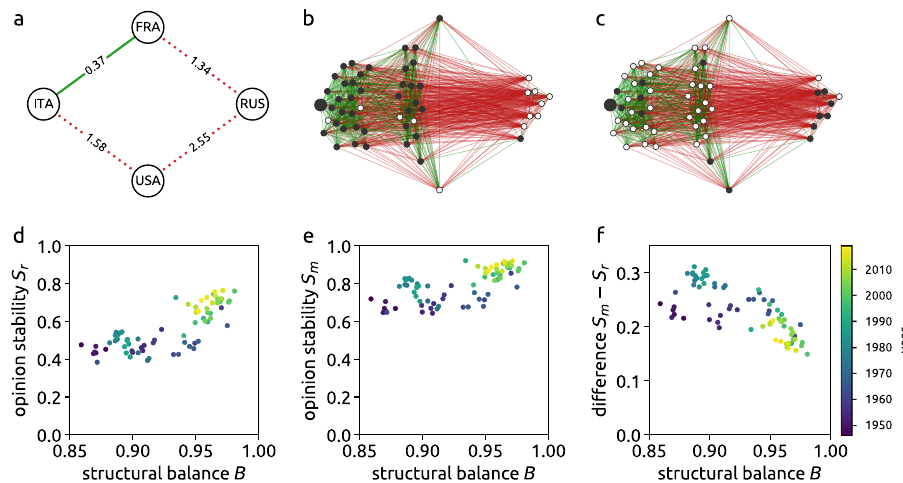
Fig. 6 Opinion stability for the United Nations General Assembly voting data. a A sample unbalanced subgraph of the last session ’ s dataset. Links are labeled with absolute differences between the states ’ ideal point positions estimated in ref. 44 . Absolute differences below the 33th percentile and above the 67th percentile are represented as positive (solid green) and negative (dotted red) links, respectively. b , c Resulting opinions in two different realizations of the random neighbor rule on the fi rst session ’ s dataset. Black and white symbols indicate positive and negative opinions, respectively. The seed opinion (indicated with a larger marker) is the same in both realizations. d – f Opinion stability achieved by the random neighbor rule ( d ) and the majority rule ( e ) plotted against the level of structural balance in input relation networks corresponding to 73 individual UN sessions (symbol color indicates the session year). Panel f shows the difference between the two